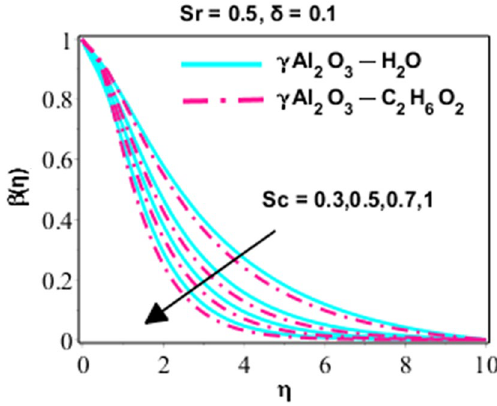
Figure 9. Character of β(η) due to the variation in Sc .